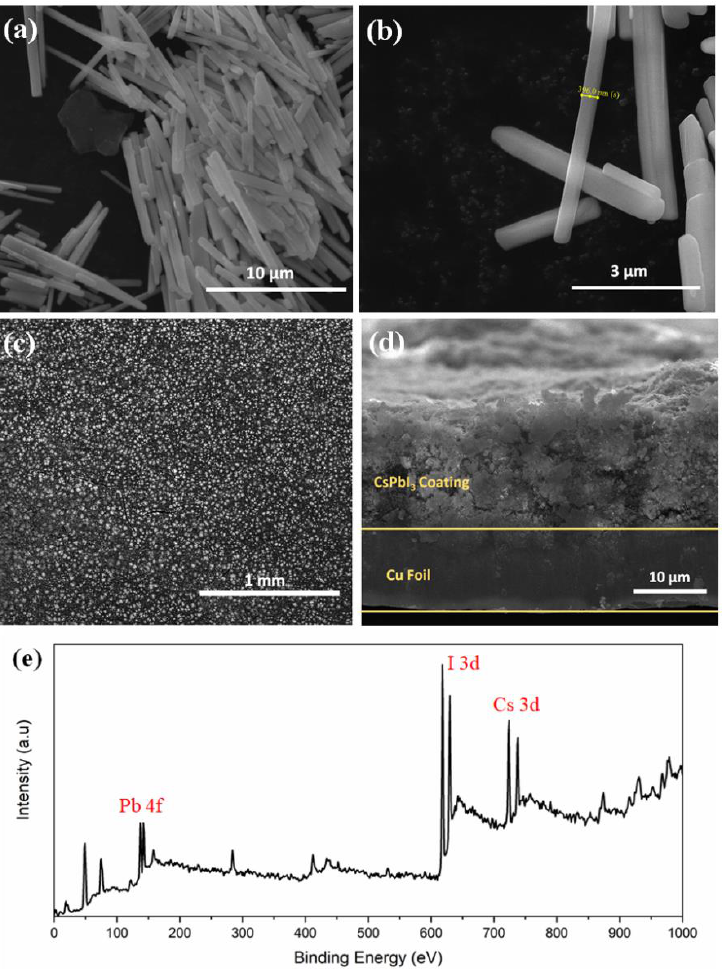
Figure 2. Morphology analysis. ( a , b ) FESEM image of as-prepared δ -CsPbI 3 using solution process at different magnifications. ( c ) Top view FESEM image of electrode using δ -CsPbI 3 and PVDF, carbon black pasted on Cu foil. ( d ) Cross-sectional FESEM image of as prepared electrode on Cu foil. ( e ) XPS survey spectrum of δ -CsPbI 3 as prepared by solution process.